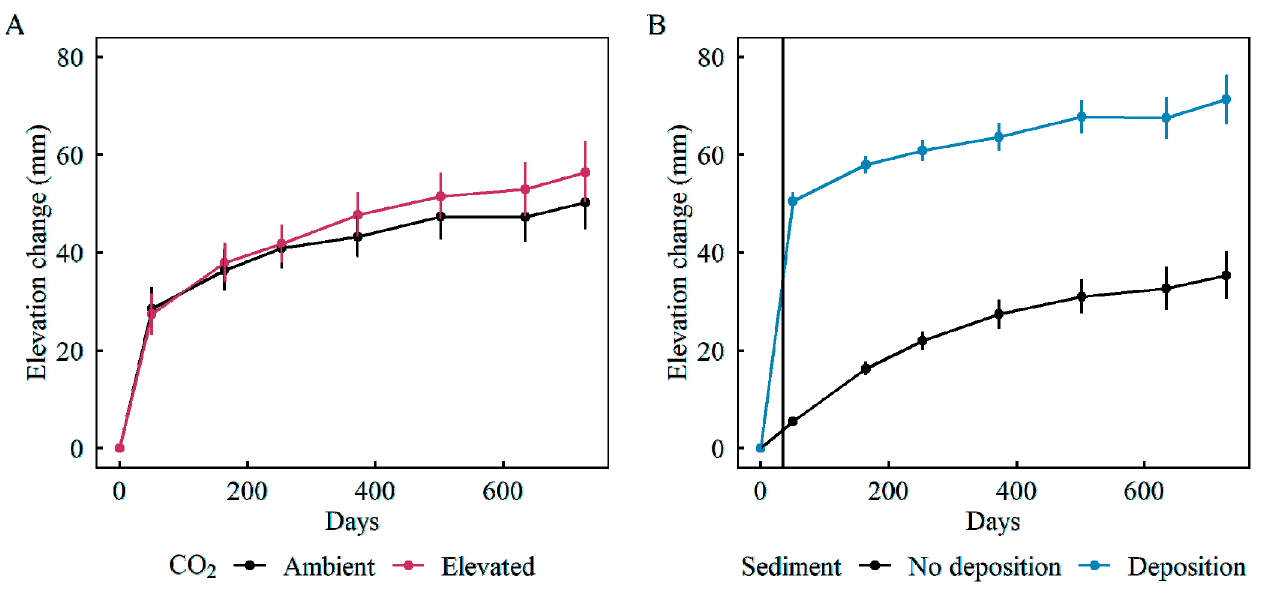
Figure 6. Incremental change in surface elevation in mesocosms over time following ( A ) ambient (black) and elevated (red) CO 2 treatments and ( B ) no sediment (black) and with sediment (blue) deposition treatments. Data points represent average surface elevation relative to baseline across all communities; brackets represent standard errors. Sediment was added on day 35 (black vertical line).